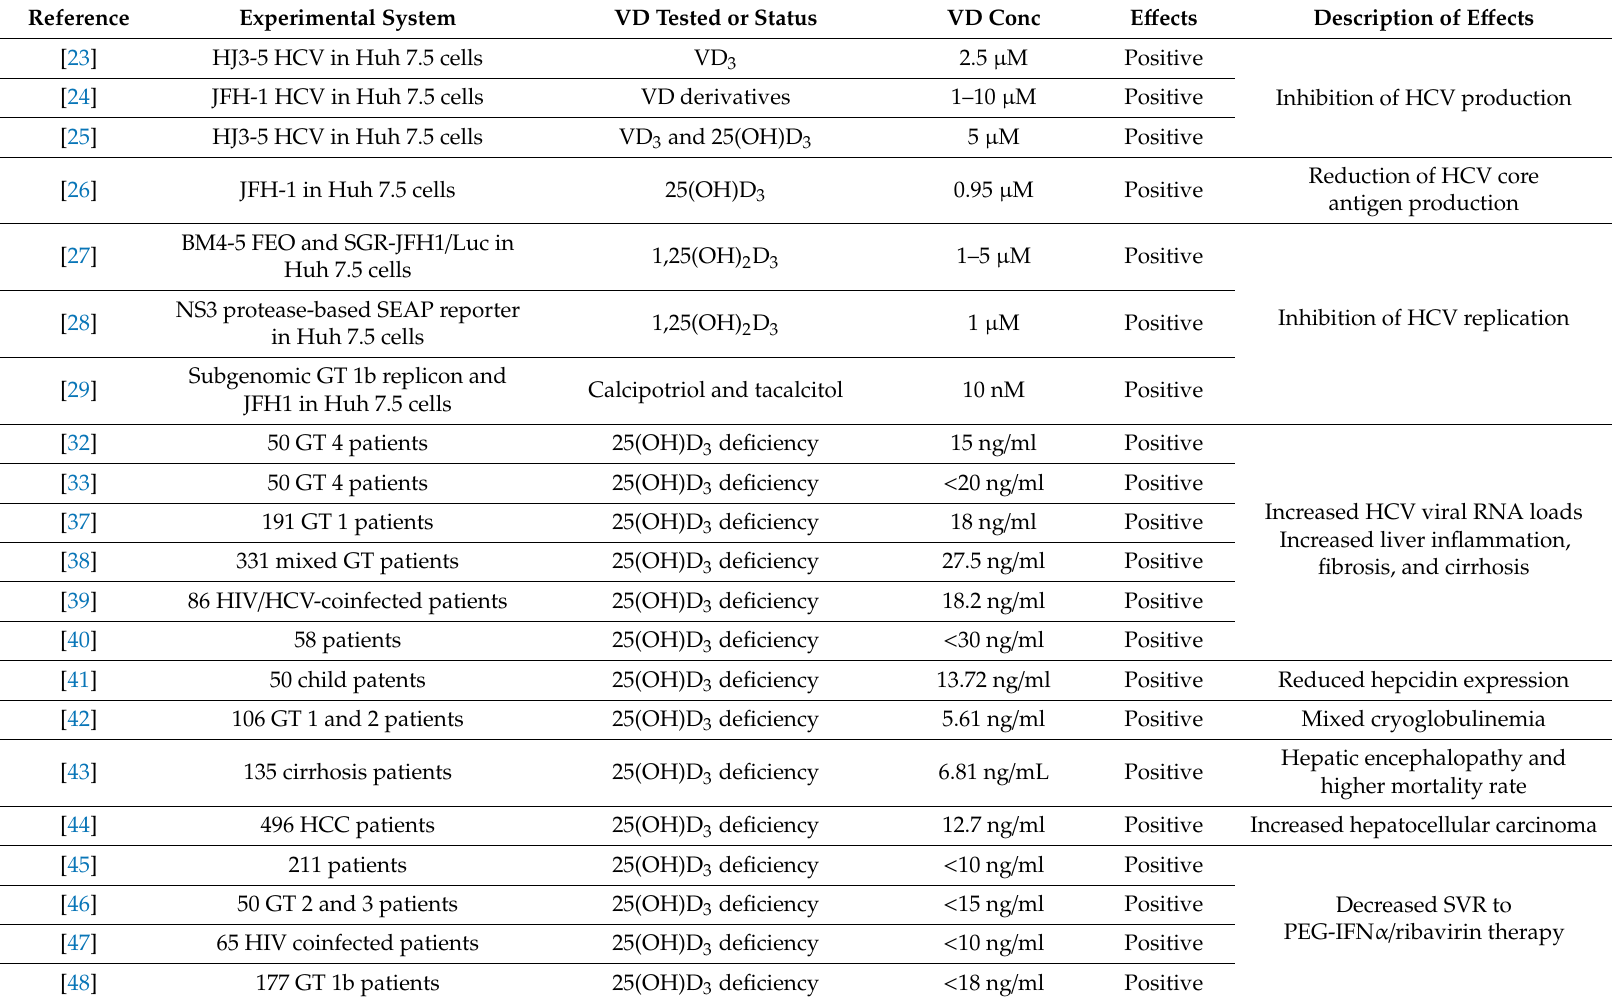
Table 1. E ff ects of VD on hepatitis C virus (HCV) infection, pathogenesis, and treatment